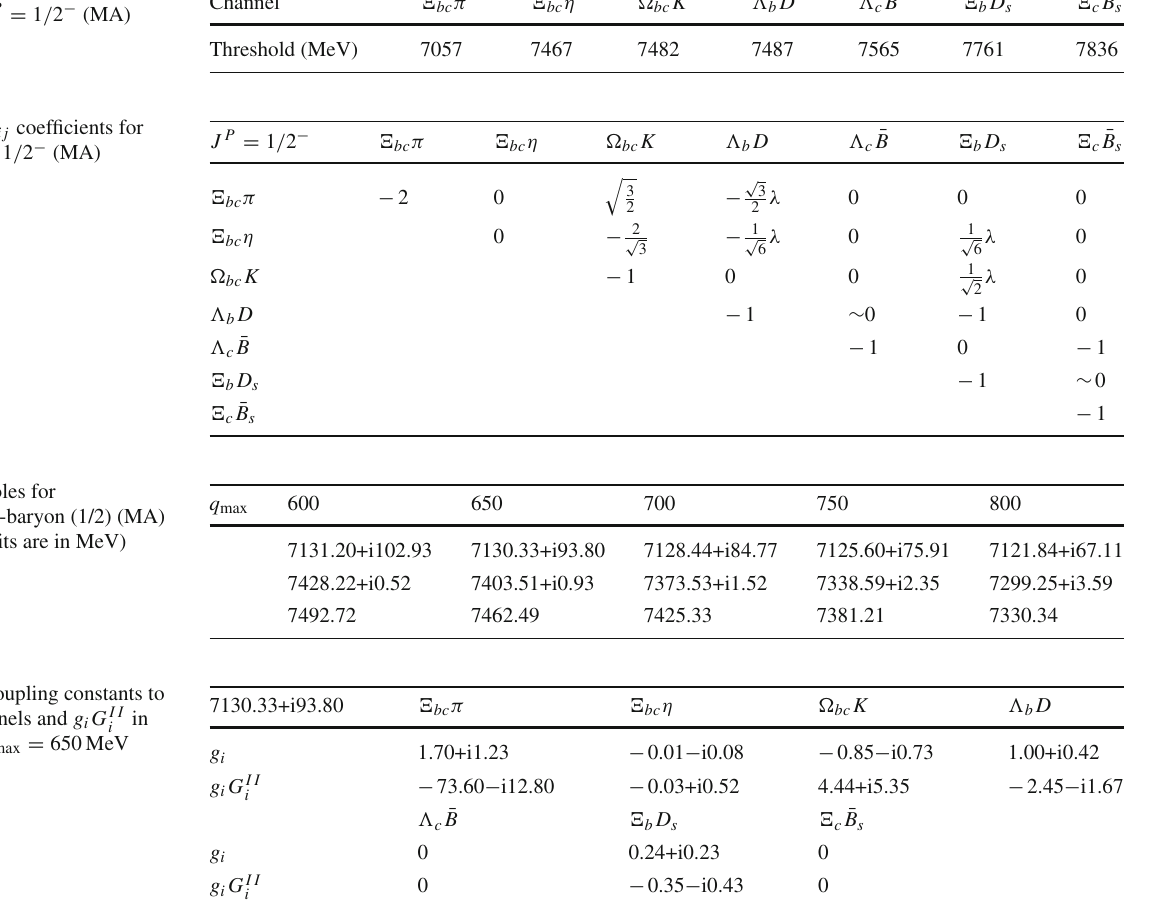
for sector J P = 1 / 2 − (MA)